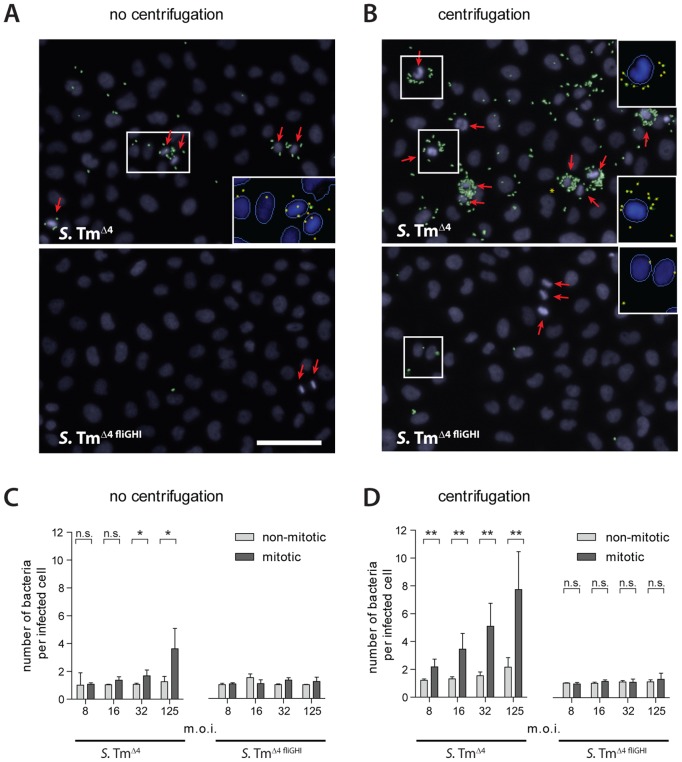
Motility determines the targeting preference of S. Typhimurium for mitotic cells.HeLa cells were infected with S.Tmwt or S.TmΔfliGH at the indicated m.o.i. for 6 min either without centrifugation (A, C) or including a centrifugation step for 10 min at 500 g (B, D), followed by staining of nuclei, extracellular bacteria (anti-LPS antibody) and automated microscopy. Using an automated analysis algorithm, nuclei and individual bacteria were detected and mitotic nuclei identified. (A, B). Representative images are shown for infections at an m.o.i. of 125. Nuclei are shown in blue, extracellular bacteria in green. The red arrows indicate mitotic nuclei. For selected parts of the image (white boxes)the automated detection of nuclei and bacteria is shown (see inserts). Please note, that our image analysis algorithm is not able to distinguish all bacteria in highly crowded regions (S.TmΔ4 and centrifugation, not shown); therefore, docking onto mitotic cells might be underestimated and our quantitative analysis below would be a conservative estimation. Scale bar: 40 µm. (C, D) Infection efficiency at the respective m.o.i. with respect to the number of docked bacteria per infected cell (non-mitotic cells, light grey; mitotic cells, dark grey). Each bar represents the median. The error bars represent the standard deviation of 6 replicas from 3 independent experiments. Approximately 5000 cells per replica were analyzed. *p<0.05, **p<0.01 (Mann-Whitney-U test). For the immotile strain(S.TmΔ4 fliGHI; no centrifugation), we did not detect enough bacteria on mitotic cells for a reliable statistical analysis.